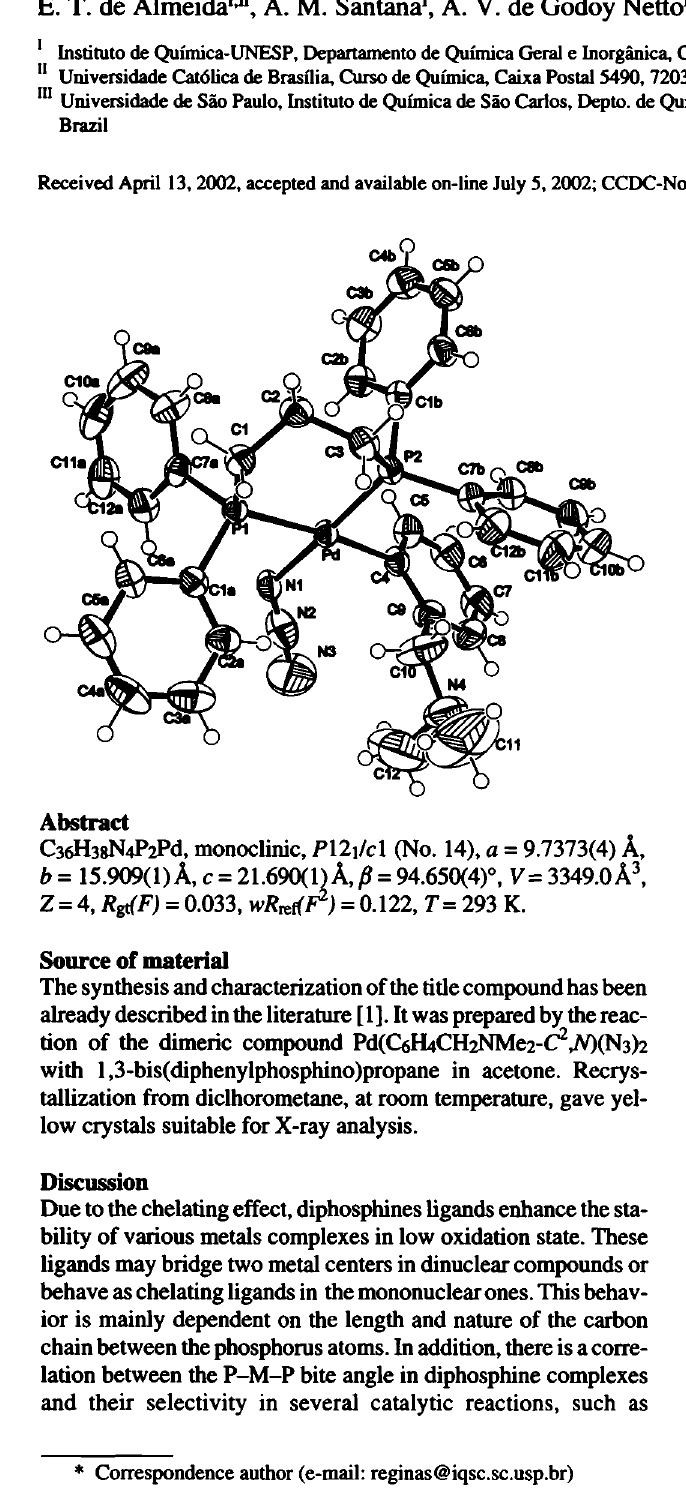
Table 1. Data collection and handling.